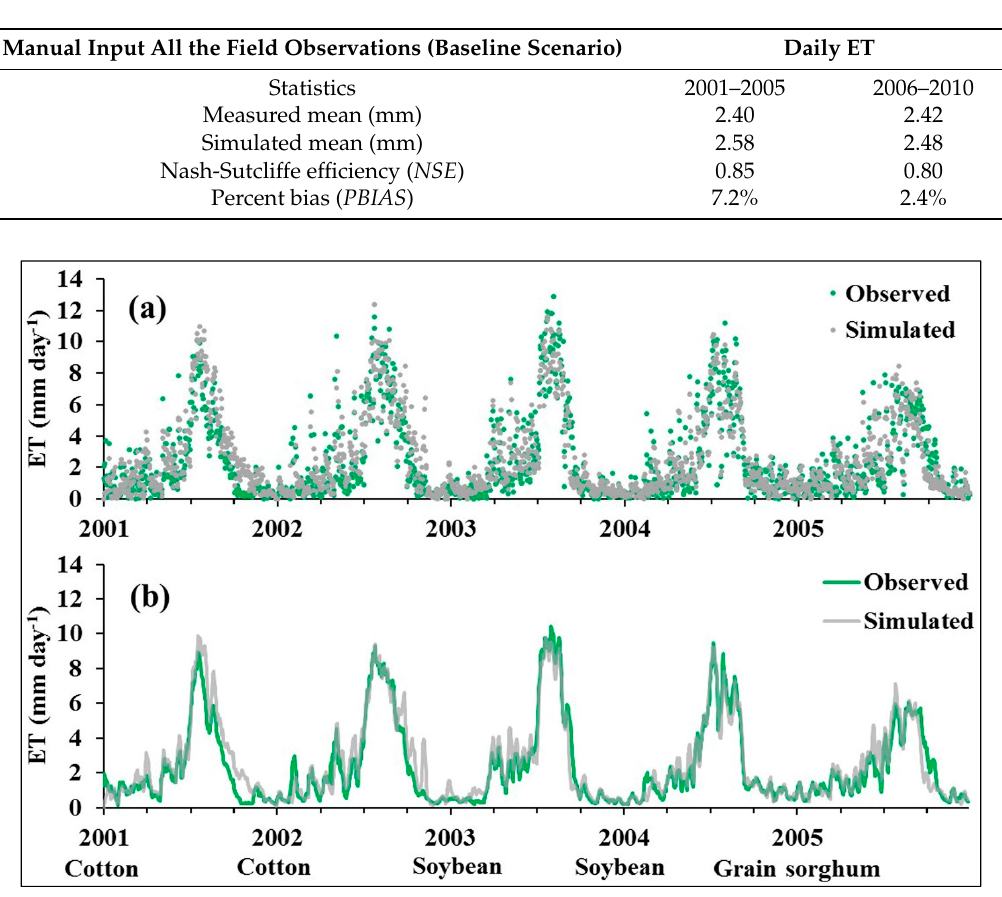
Table 5. Model performance statistics for daily measured and simulated ET during calibration (2001– 2005) and validation (2006–2010) periods.